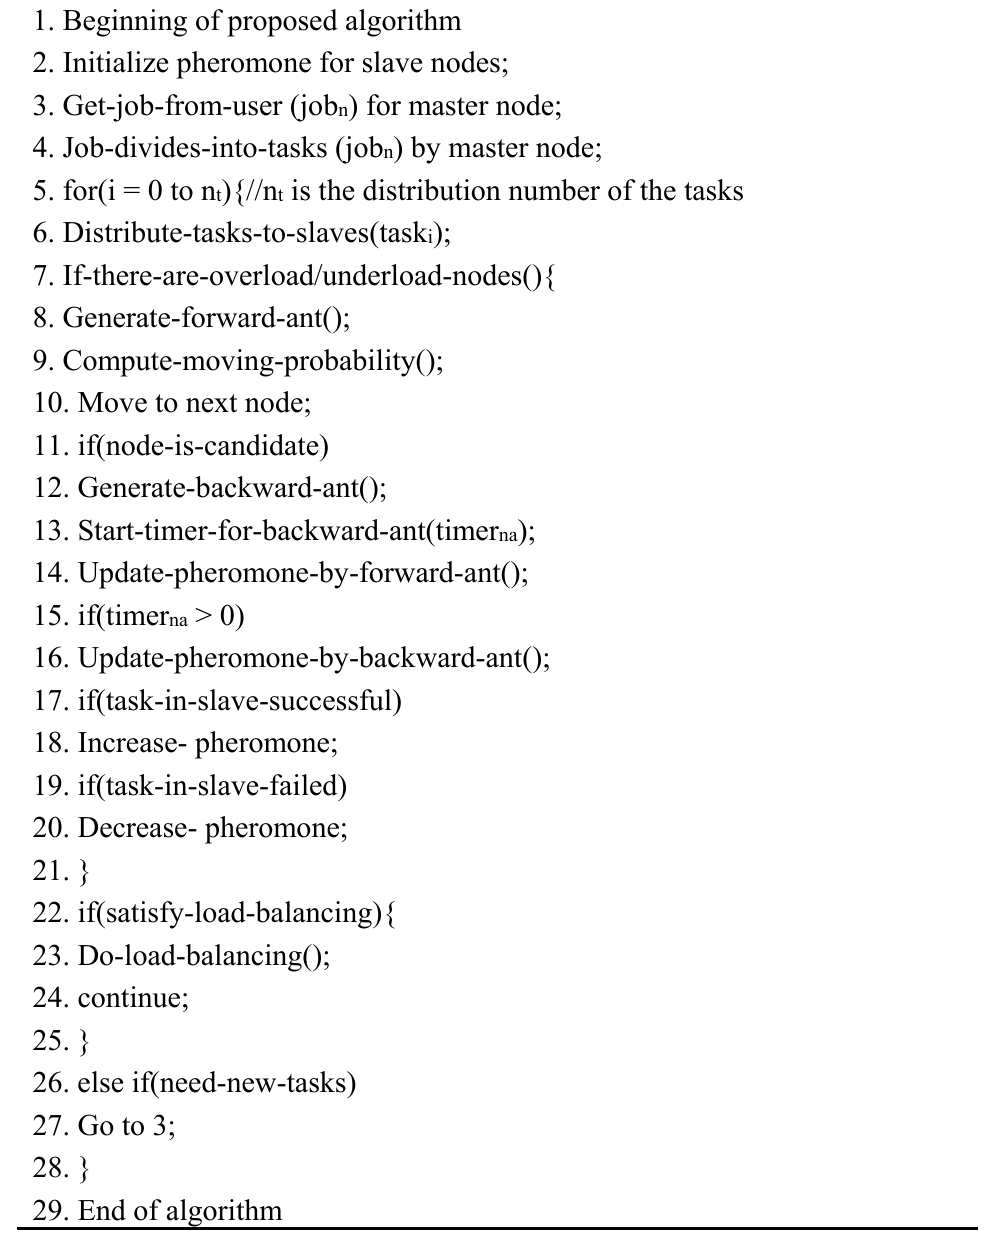
Algorithm 1 The step by step procedure of the proposed load